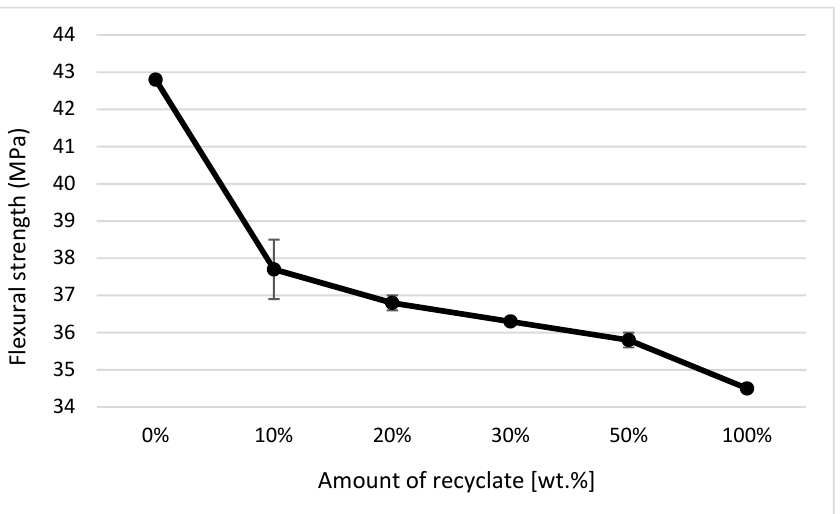
Figure 18. Dependence of the flexural strength on the amount of the recycled material before exposing the samples to elevated temperature.